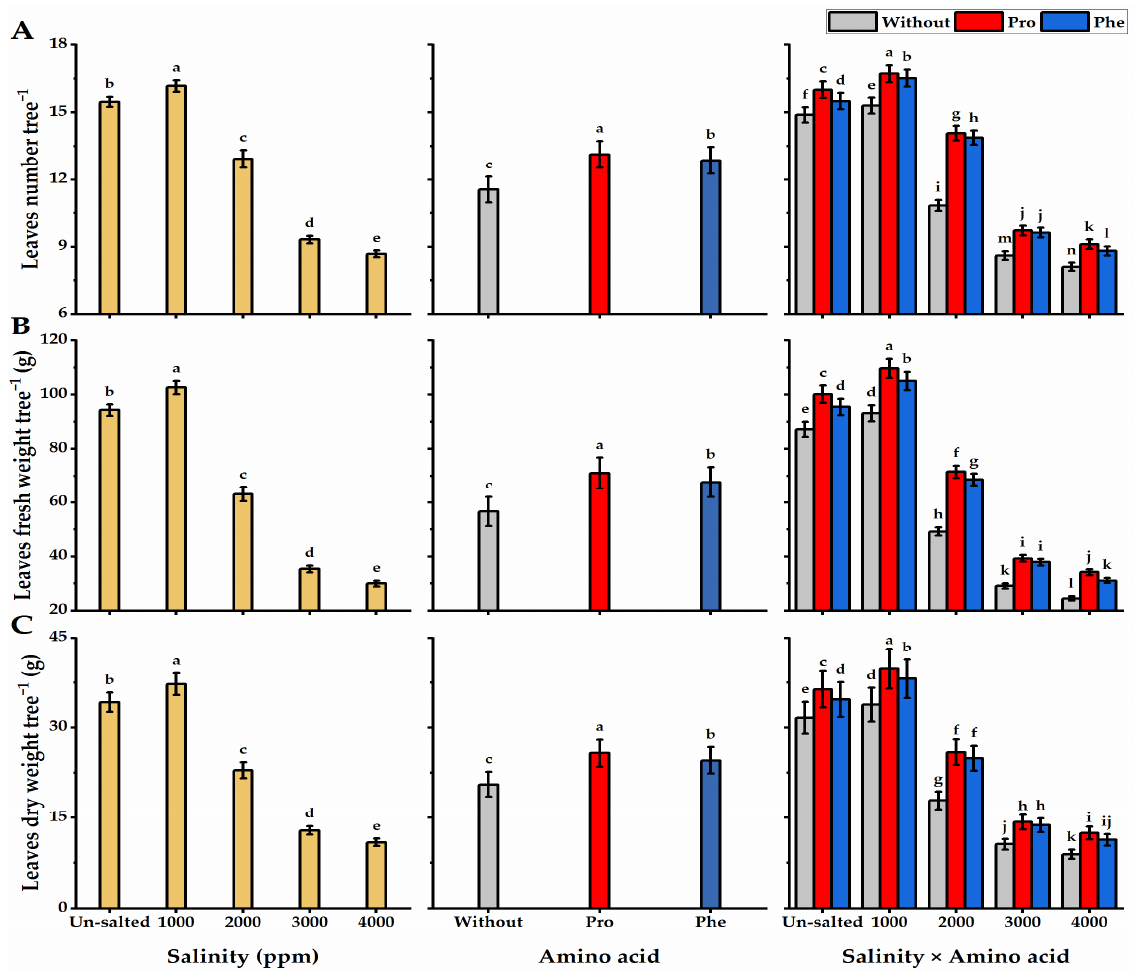
Figure 2. Influence of exogenous spray treatments of proline (Pro) or phenylalanine (Phe) on ( A ) leaves number, ( B ) leaves fresh weight, and ( C ) leaves dry weight tree − 1 of moringa trees cultivated under different levels of salinity. Data are mean value ± SE. Bars with different letters are significantly different at p ≤ 0.05